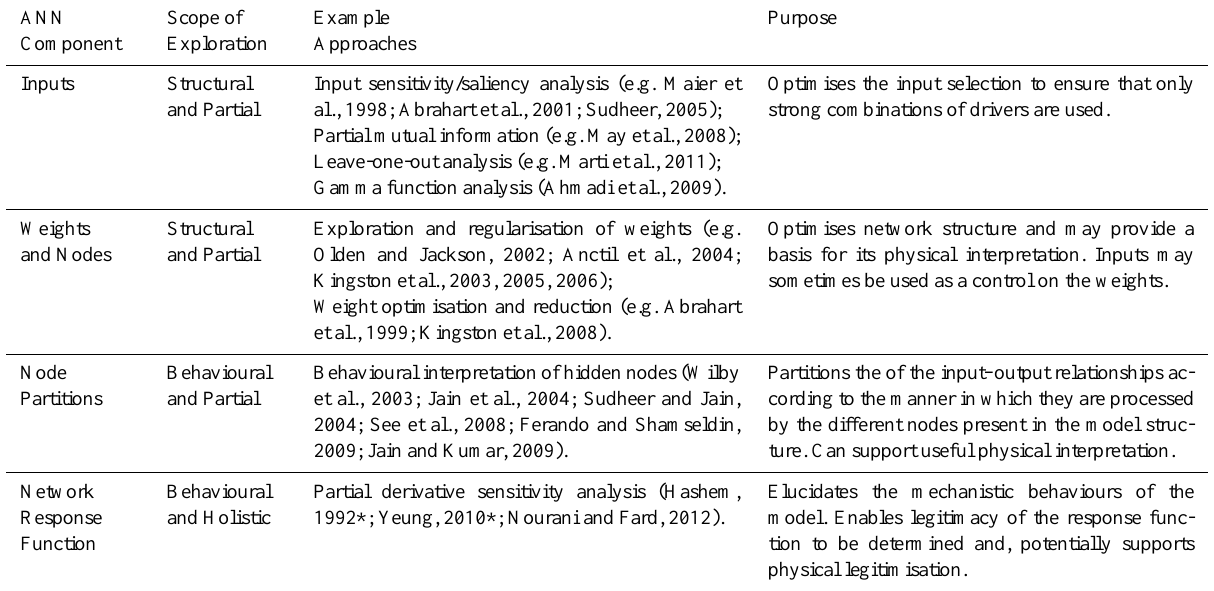
Table 7. Example approaches to exploring and justifying ANN-based hydrological models. ANN Scope of Example Component Exploration Approaches